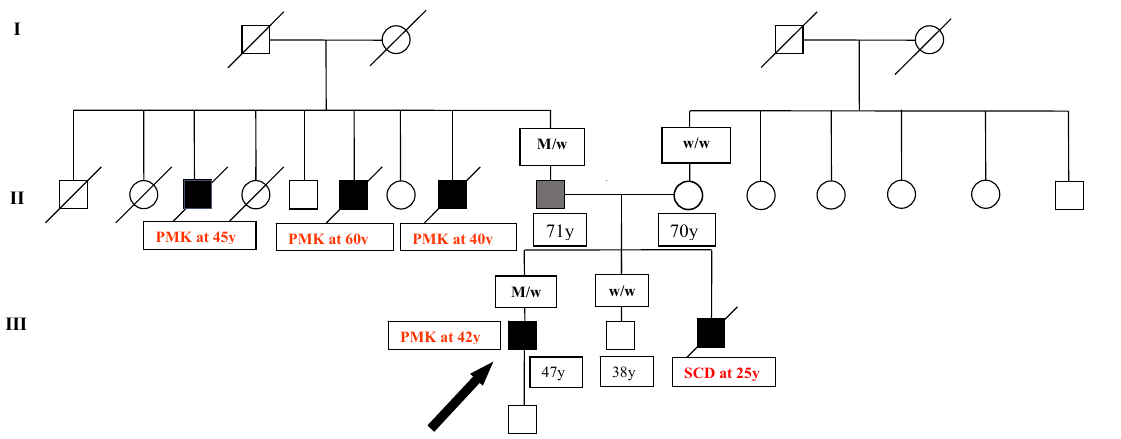
Figure 2. Pedigree of the family. Family members are identified by generations. Squares = males; circles = females; black symbols = affected individuals; white symbols = unaffected individuals; grey symbol = individual carrying TRPM4 gene mutation, without AVB; arrow = the proband; M/w = people carried TRPM4 mutation; w/w = people without TRPM4 gene mutation.